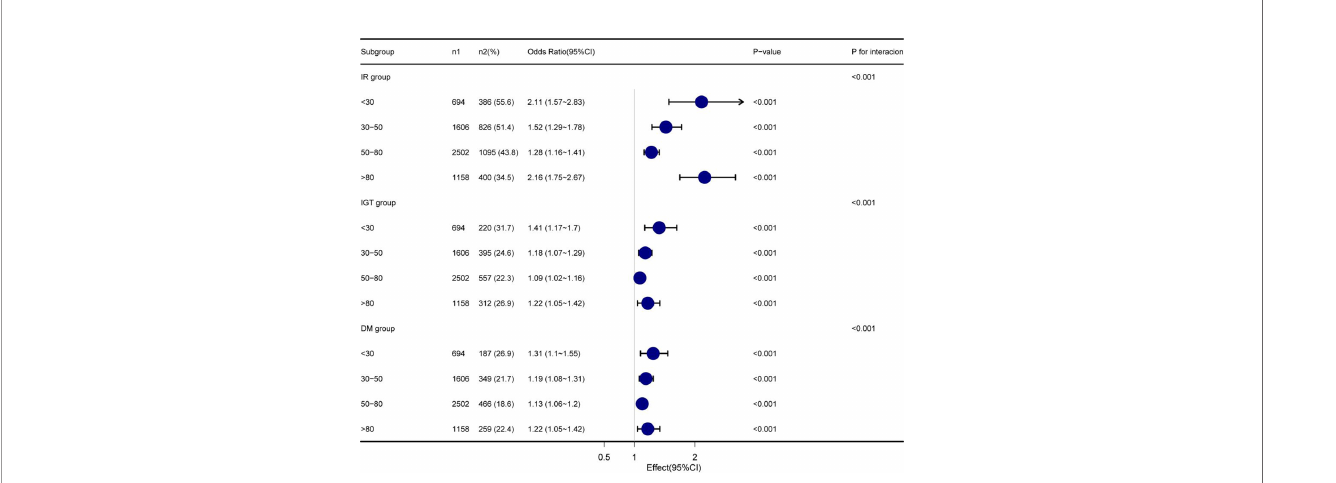
FIGURE 3 | Subgroup analysis based on the multivariate logistic regression analysis of the association between TG/HDL ratio and IR, IGT, and DM. TG/HDL, triglycerides/high-density lipoprotein; IR, insulin resistance; IGT, impaired glucose tolerance; DM, diabetes